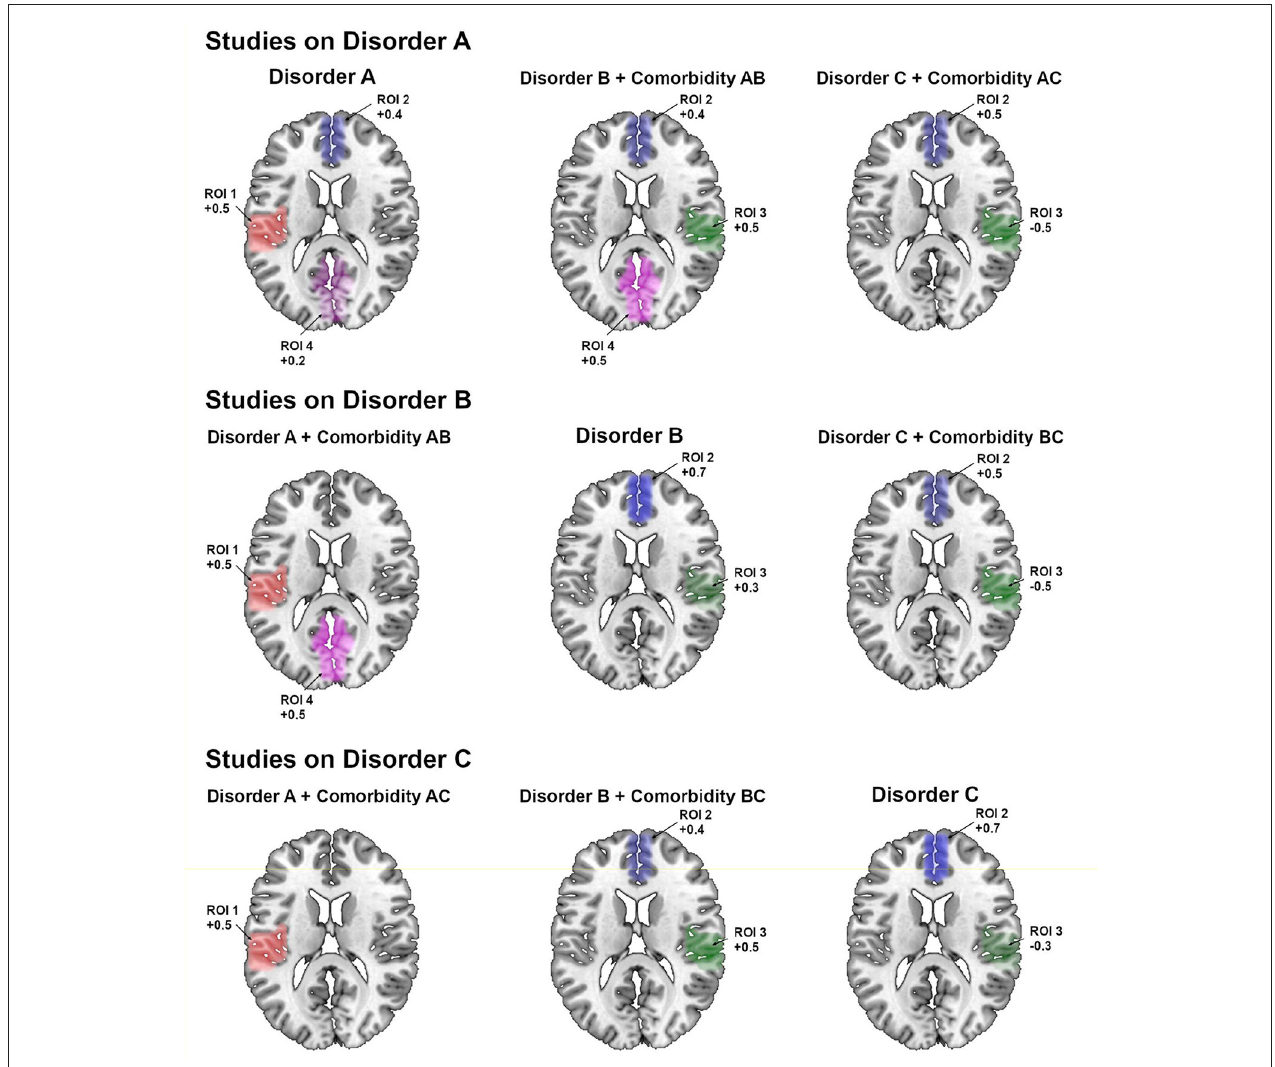
FIGURE 3 | Regions showing statistically significant effects using the previous SDM-PSI approach (separate results for meta-analysis of studies on disorder A, meta-analysis of studies on disorder B, and meta-analysis of studies on disorder C). ROI, region of interest.